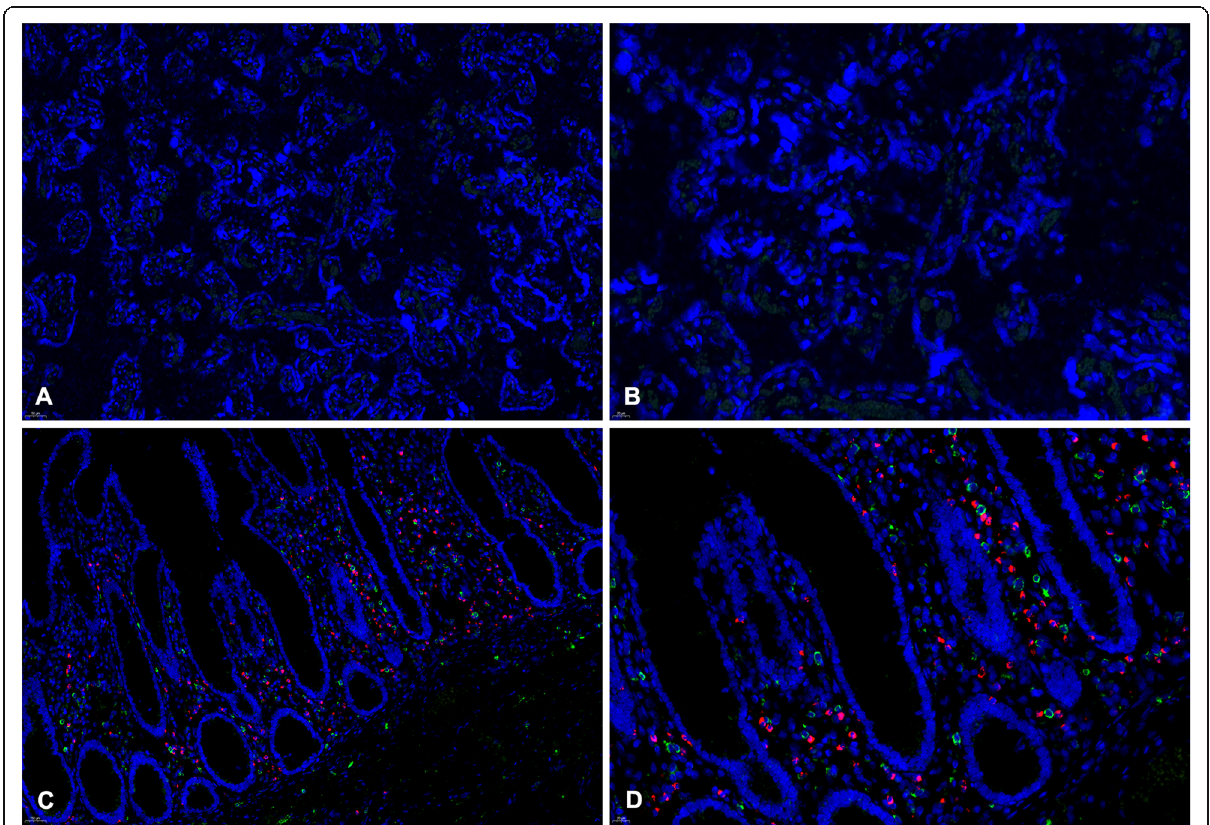
Fig. 3 IF and FISH double staining result of SARS-CoV spike protein (green) and SARS-CoV-2 RNA (red) in all eight cases and positive control. a , Original magnifications × 200) and b , Original magnifications × 400):no positive signal was presented of monoclonal antibody against SARS-CoV spike protein (green) and SARS-CoV-2 RNA (red) in all eight cases by IF and FISH double staining. c , Original magnifications × 200) and d , Original magnifications × 400): both of positive signal were presented in acolon tissue with COVID-19 infection as positive